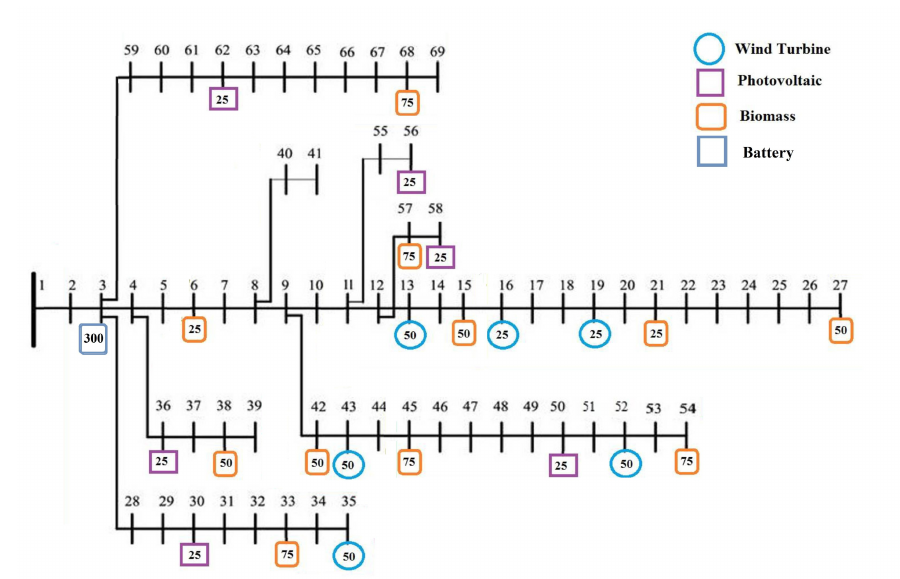
Figure 2. The used IEEE PG & E 69 bus